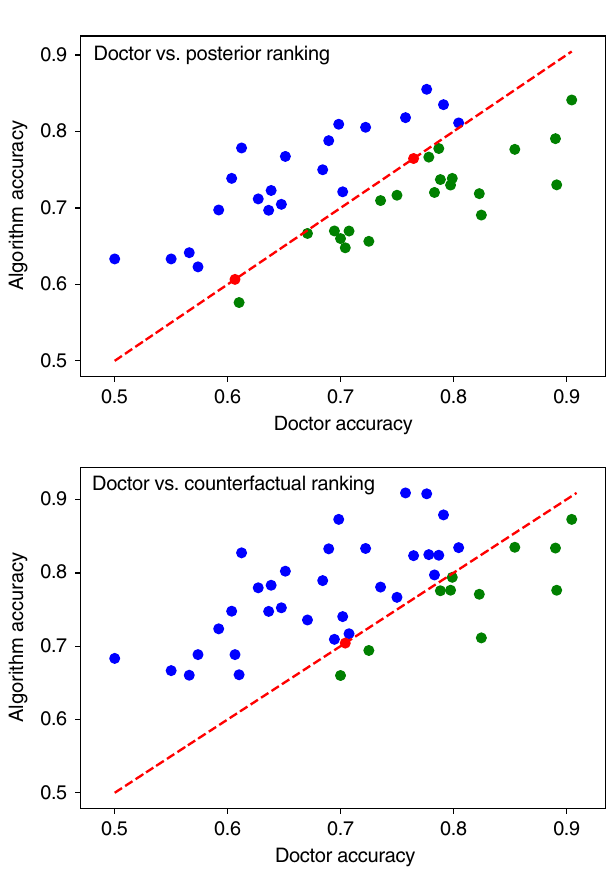
Fig. 4 Mean accuracy of each doctor compared to Bayesian and counterfactual algorithms. Figure shows the mean accuracy for each of the 44 doctors, compared to the posterior ranking (top) and expected suf fi ciency ranking (bottom) algorithms. The line y = x gives a reference for comparing the accuracy of each doctor to the algorithm shadowing them. Points above the line correspond to doctors who achieved a lower accuracy than the algorithm (blue), points on the line are doctors that achieved the same accuracy as the algorithm (red), and below the line are doctors that achieved higher accuracy than the algorithm (green). The linear correlation can be explained by the variation in the dif fi culty of the sets of vignettes diagnosed by each doctor. Sets of easier/harder vignettes results in higher/ lower doctor and algorithm accuracy scores. As the results for the expected disablement and expected suf fi ciency are almost identical, we show only the results for the expected suf fi ciency. Complete results are listed in the Supplementary Table 3. All fi gures generated using matplotlib version